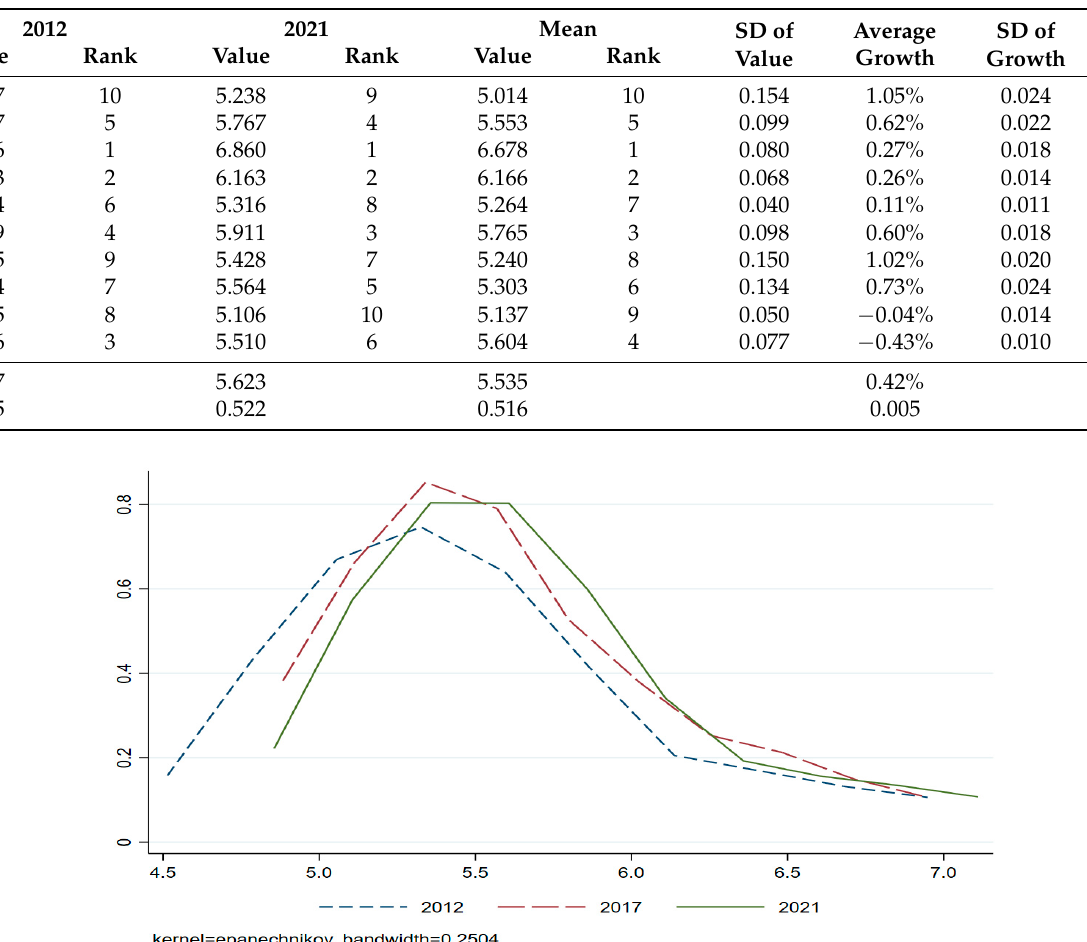
Figure 5. Kernel density map of the composite index of international competitiveness for all forest products in the countries observed.